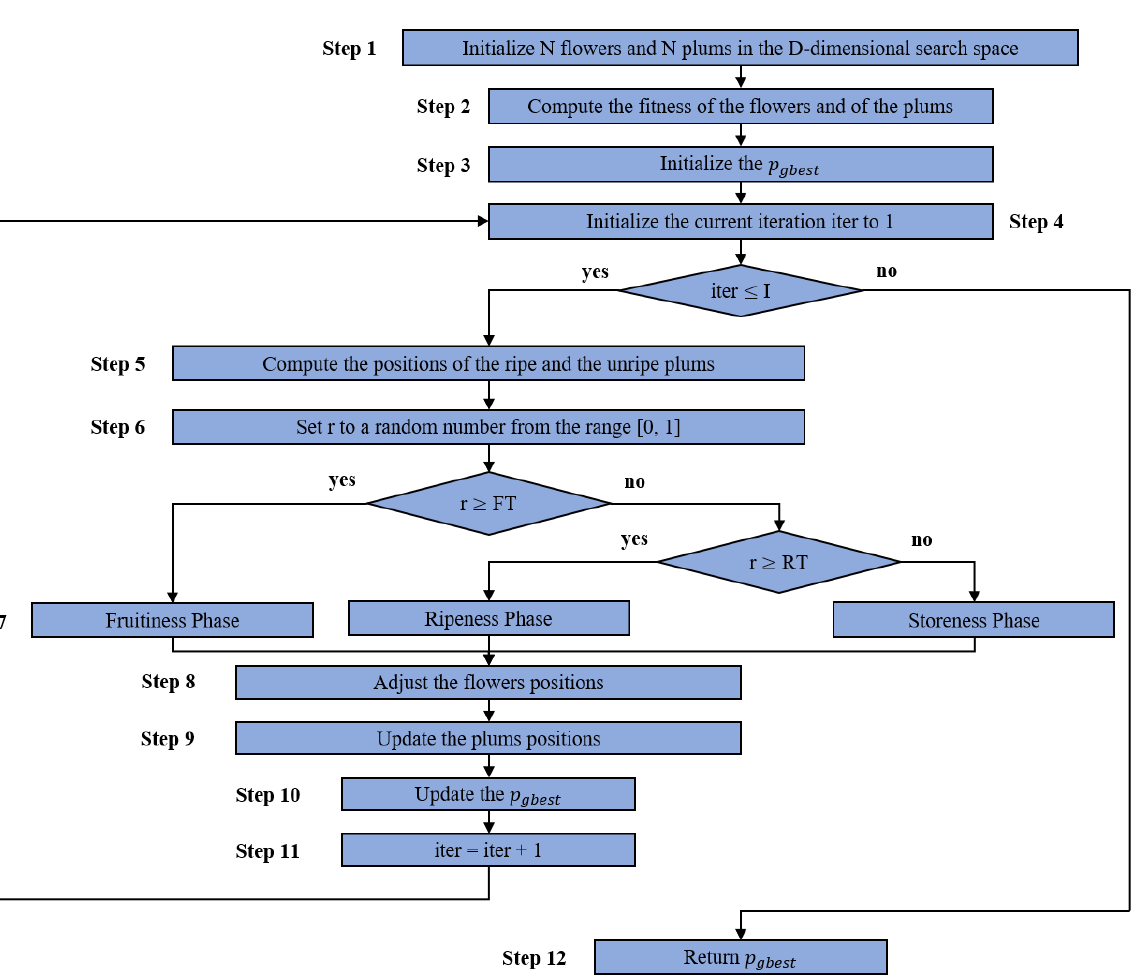
by their 𝐹𝑇 and 𝑅𝑇 thresholds. The flowers’ positions are adjusted to be within the limits of the search space (Step 8), and the positions of the plums are updated using Formula (7) (Step 9). The 𝑝 𝑔𝑏𝑒𝑠𝑡 is updated if there exists a plum which has a better fitness value (Step 10), the current iteration 𝑖𝑡𝑒𝑟 is incremented by 1 (Step 11), and the algorithm returns the 𝑝 𝑔𝑏𝑒𝑠𝑡 value after all 𝐼 iterations have been performed (Step 12). The pseudo-code of the PTA is presented below (see Algorithm 1).